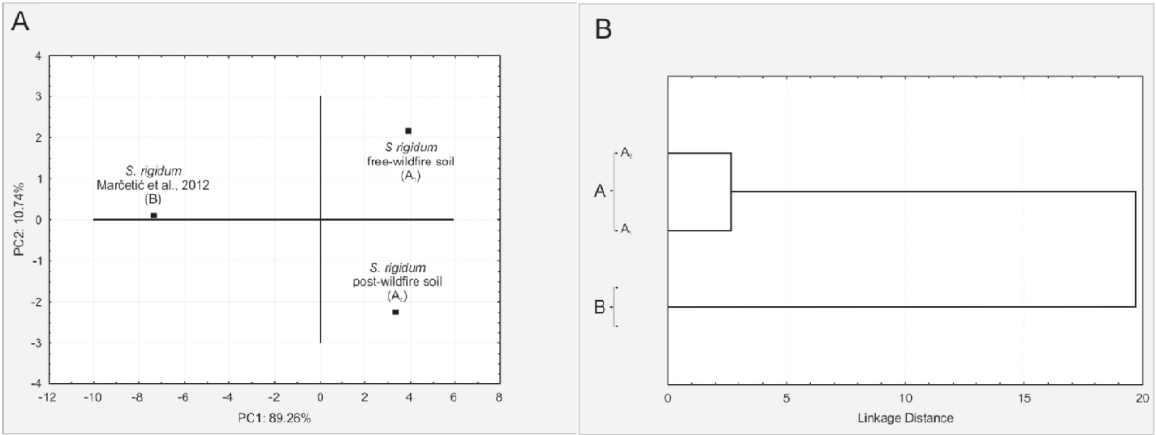
Figure 1: PCA and HCA of essential oils based on their composition: (A) the score plot of tested essential oils; (B) the corresponding dendrogram. Examined chemical compounds are presented by numbers (Table